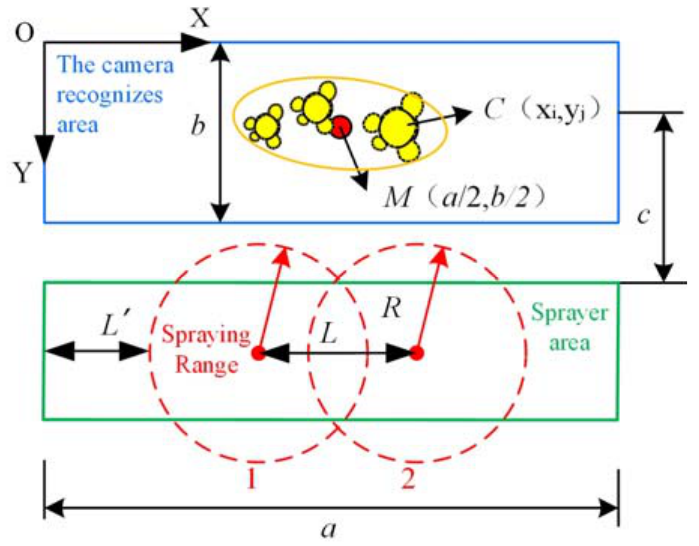
Figure 9. Projection method for target crop coordinates principle. In the nozzle coordinate system, the detected blades are normalised to n blade centre- of-mass coordinates and output as one coordinate: